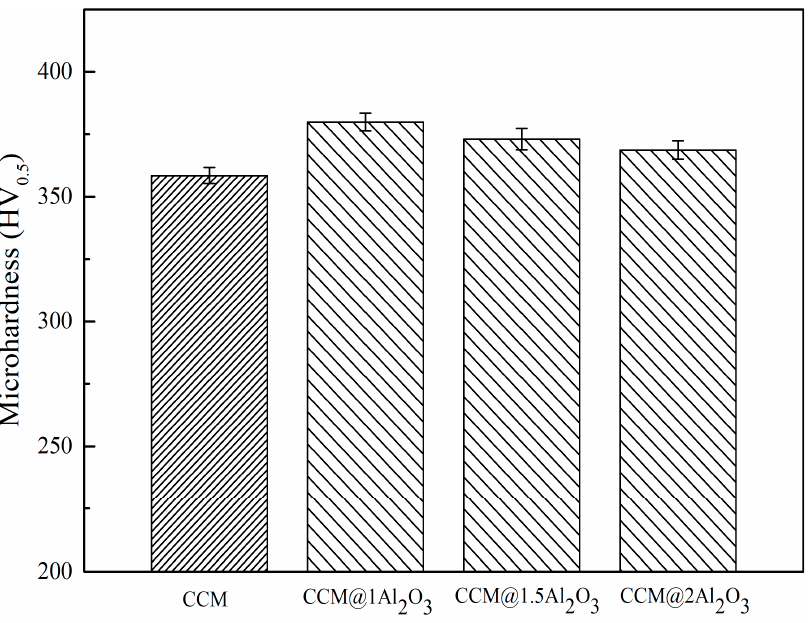
Figure 12. Microhardness of the LPBF-processed parts.